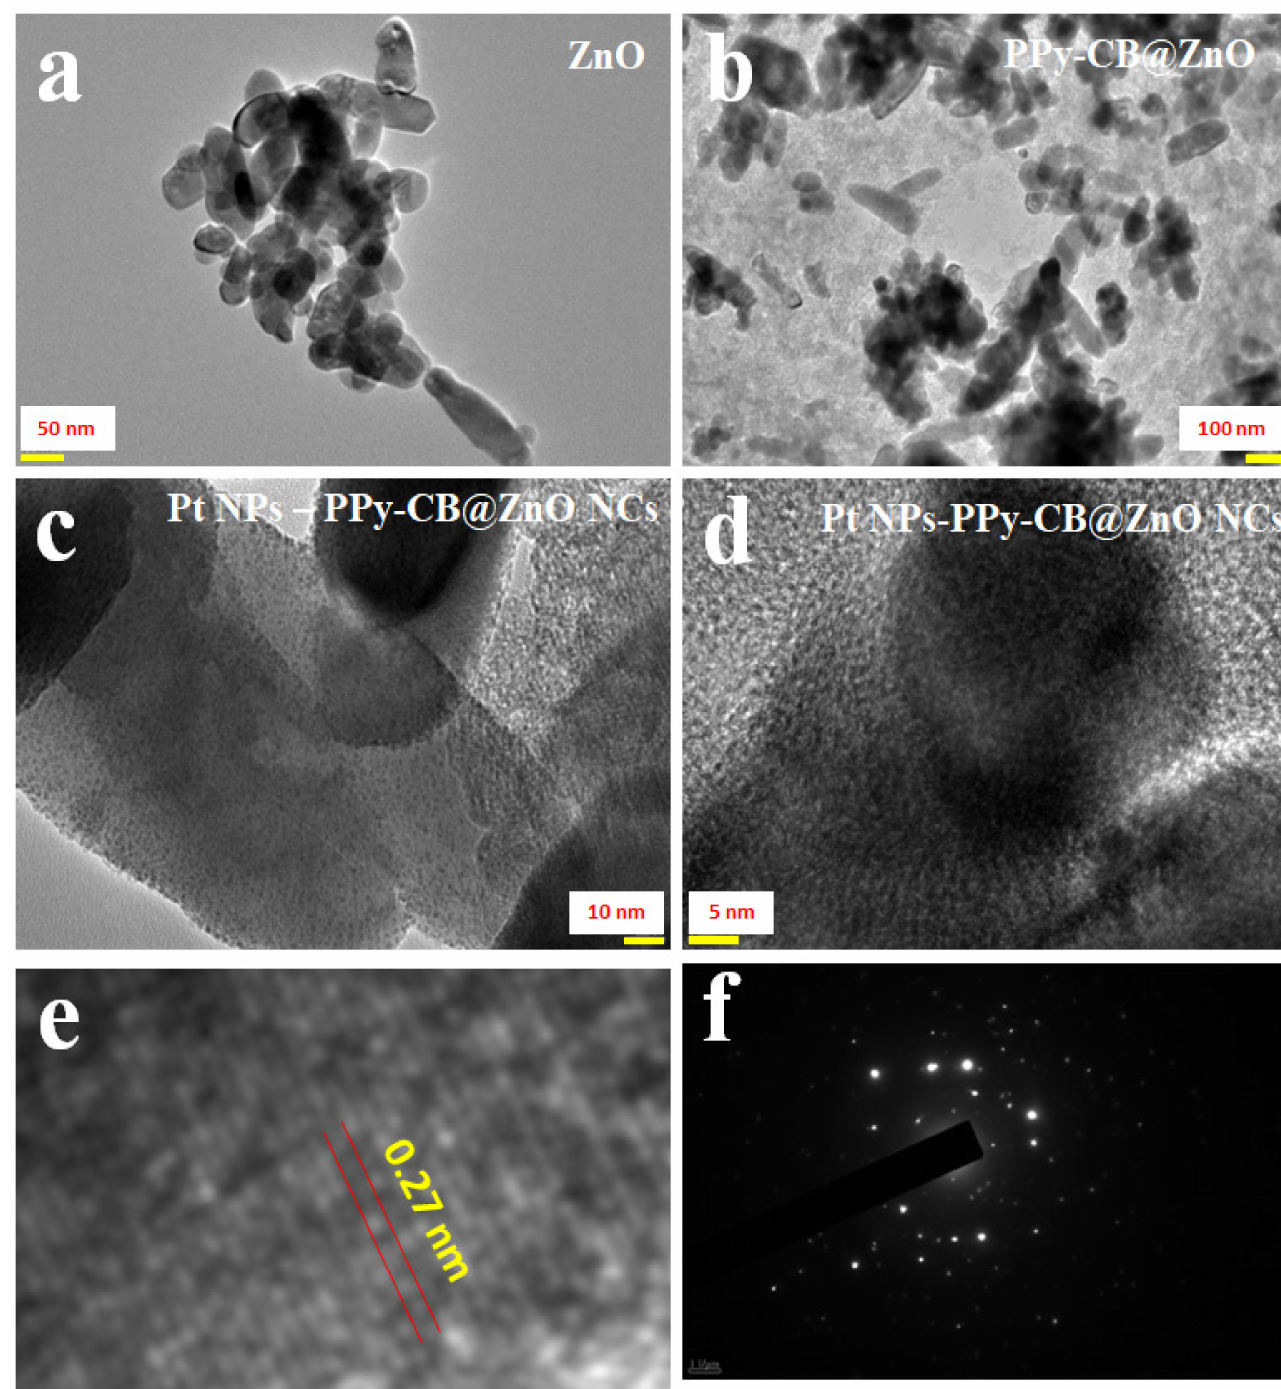
Figure 3. HRTEM analysis of Pt NPs-embedded PPy-CB@ZnO NCs; ( a ) ZnO, ( b )